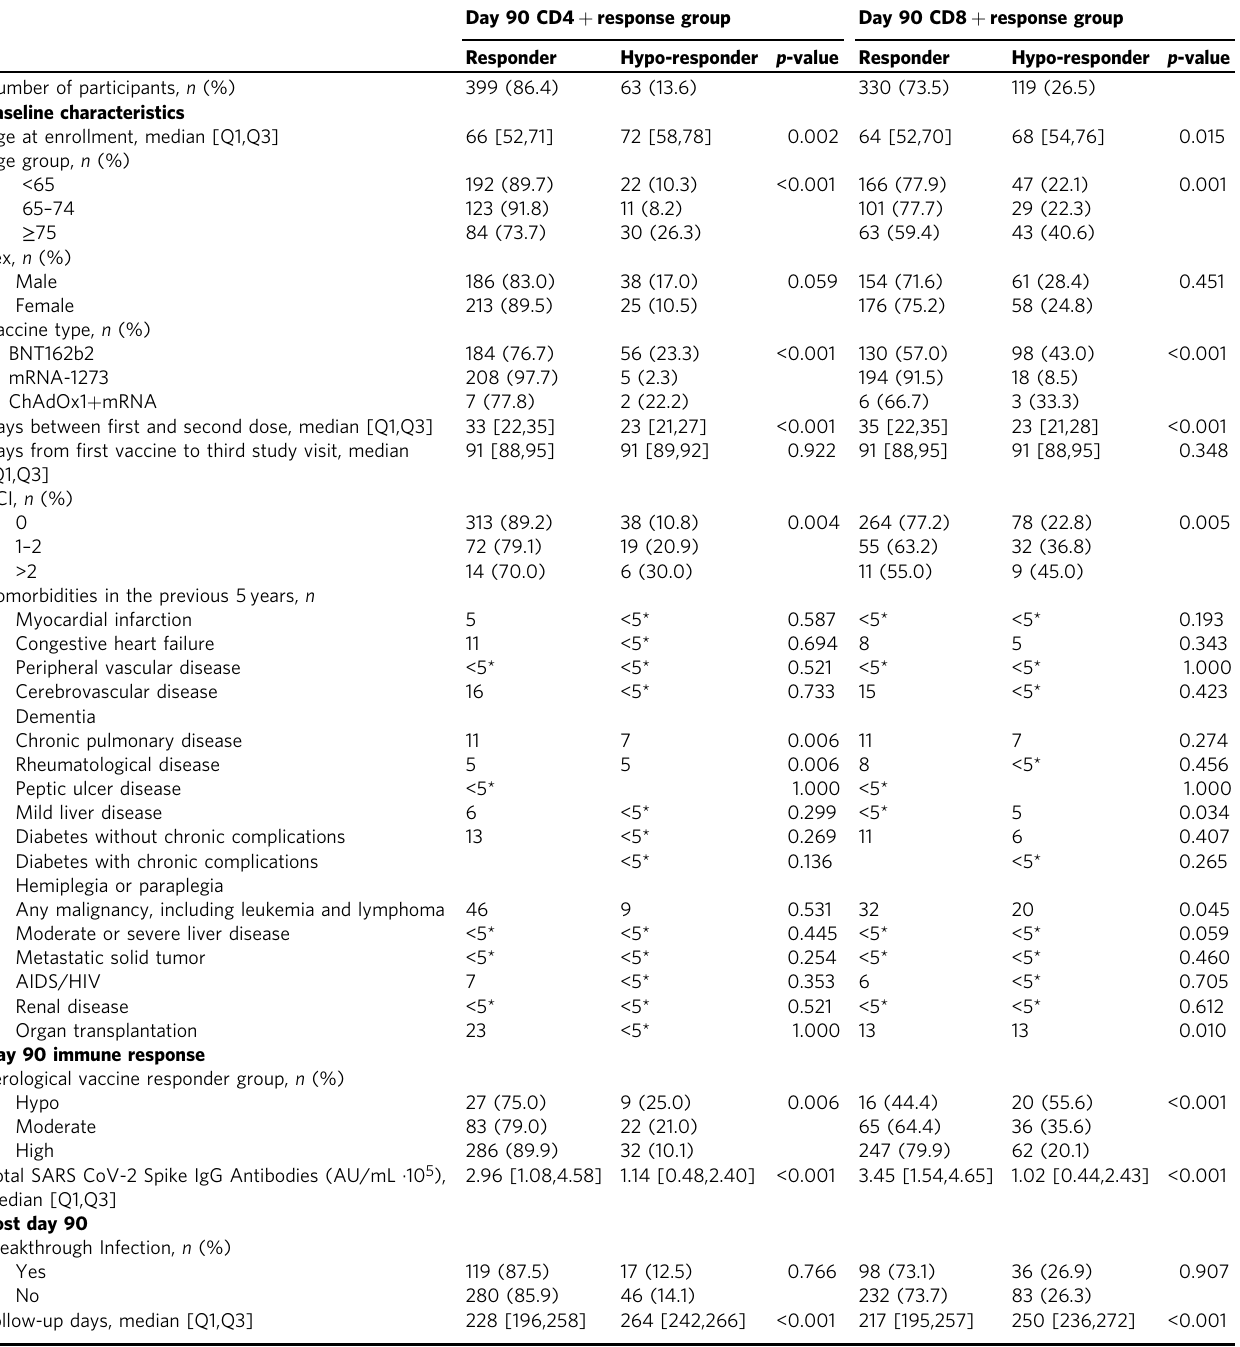
Table 2 Vaccine responder group for CD4 + and CD8 + T cells at day